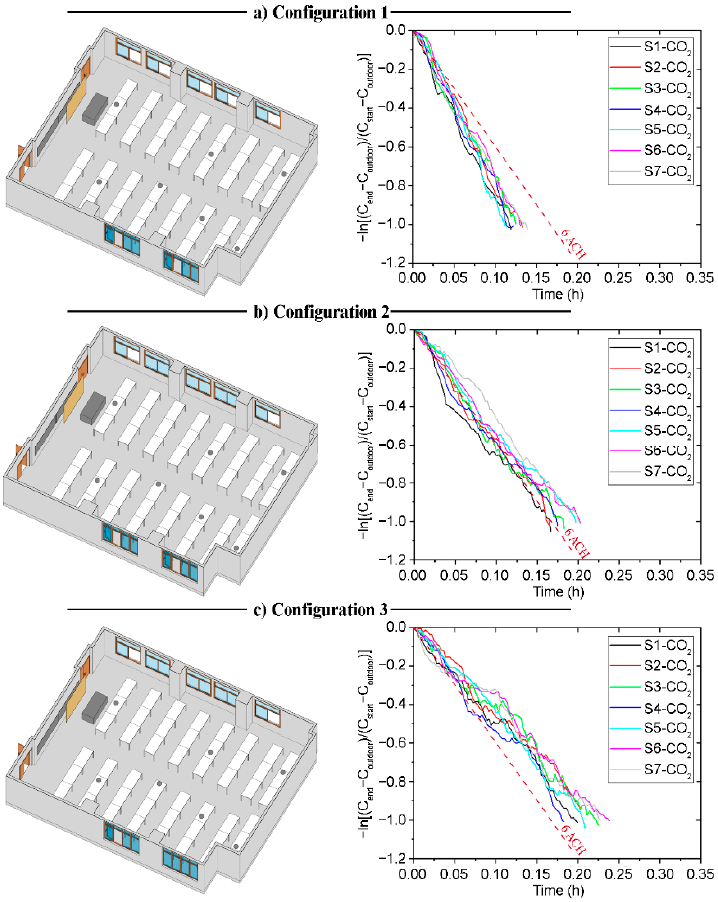
Figure 3. Configuration schemes and decay curves in Classroom B1-A1; ( a ) Configuration 1; ( b ) Configuration 2; ( c ) Configuration 3.